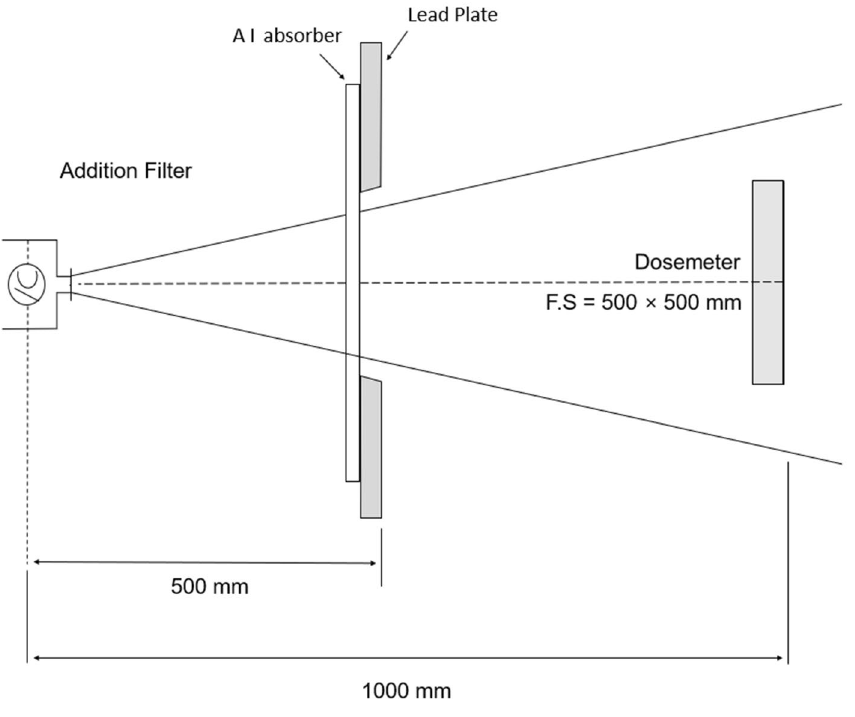
Figure 7. Measuring arrangement for half-value